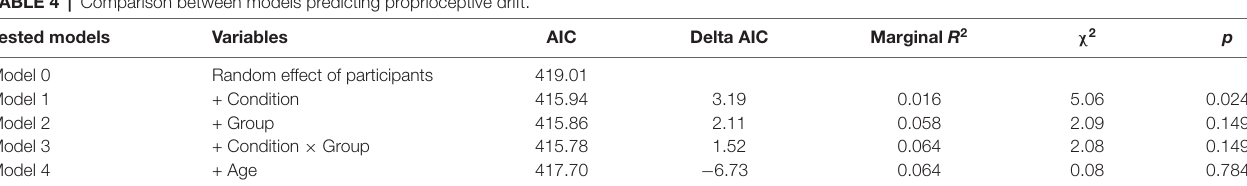
TABLE 4 | Comparison between models predicting proprioceptive